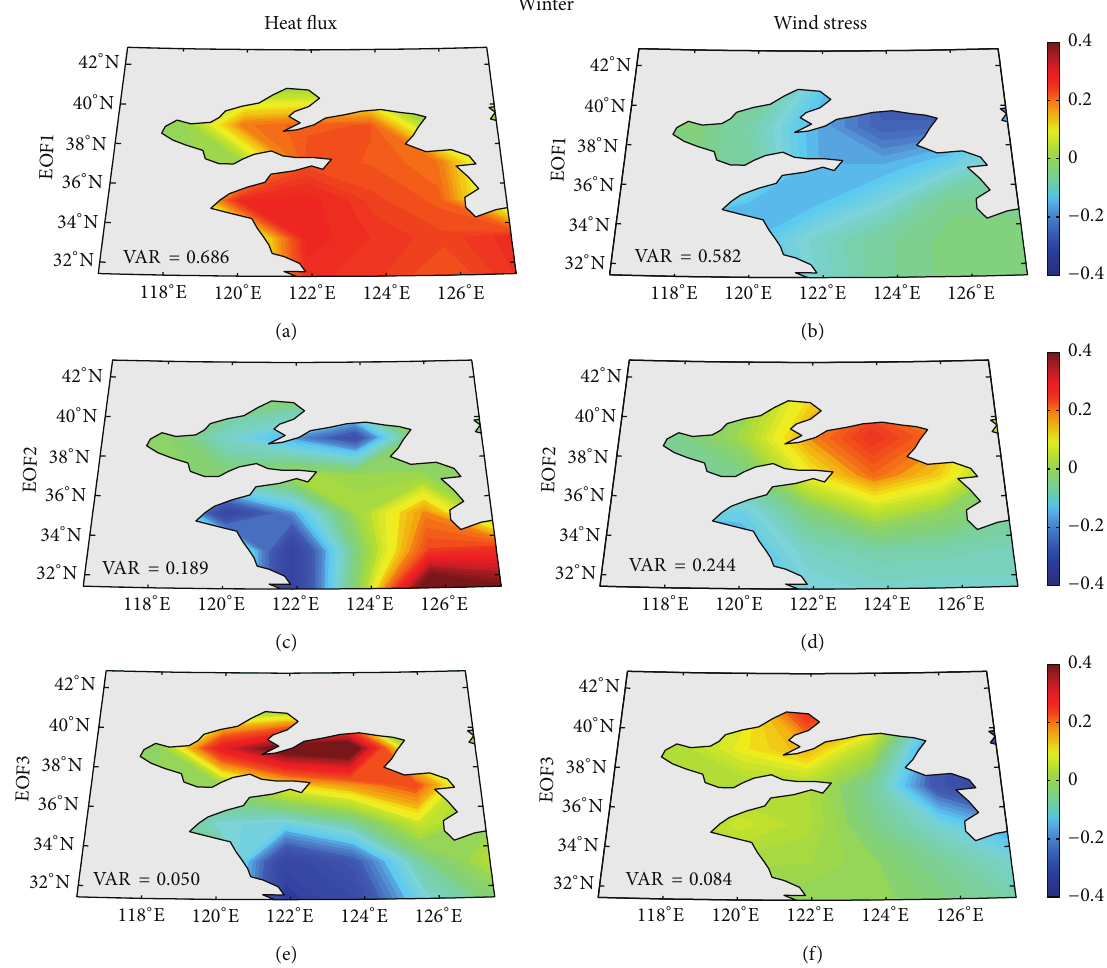
Figure 5: EOF1, EOF2, and EOF3 of interannual component for winter heat flux ((a), (c), and (e)) and winter wind stress ((b), (d), and (f)). Positive values indicate that heat is transferred from the ocean to the